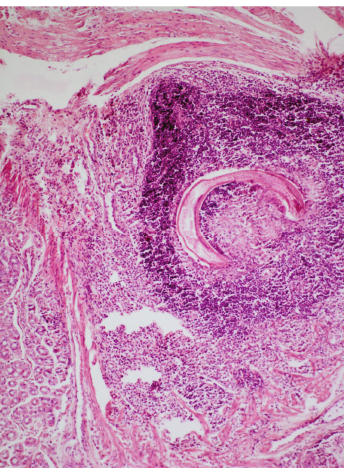
Figure 3: Section of stomach of a rabbit with the longitudinally cut larva of P. sexalatus in the submucosa; parasite is surrounded by a large rim of inflammatory cells-lymphocytes, eosinophils, and connective tissue (H. E. original magnification × 100X).